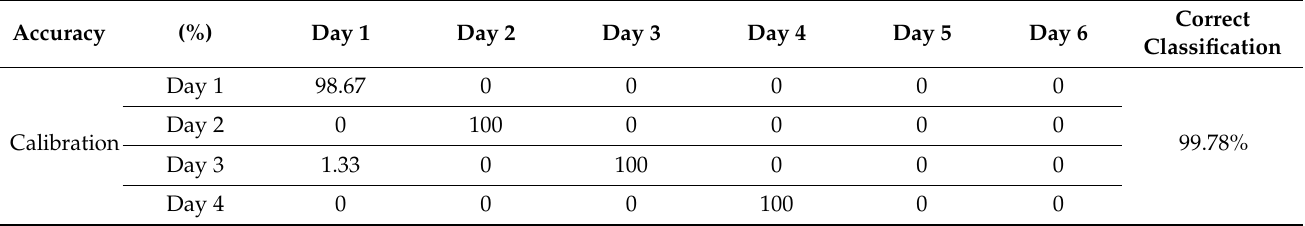
Table 2. PCA ‐ LDA classification results on the data of outer leaves when “storage time” was the class variable (deTr ‐ treated spectra, N = 450, NrPCs = 30).